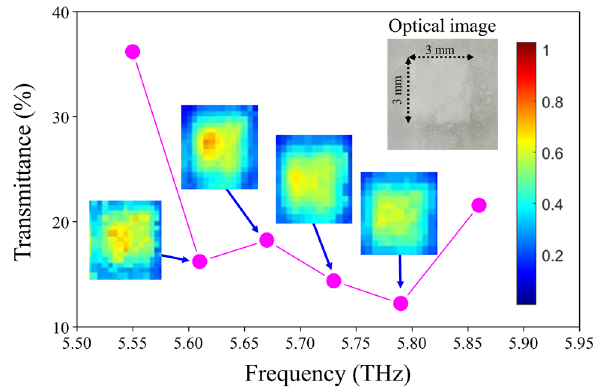
Figure 5. Spectral imaging of Aprovel powders. The characteristic transmittance curve of Aprovel powders between 5.55 and 5.87 THz. Insets: (false color) The THz transmittance images of the Aprovel powders between two polyethylene films scanned at 5.61, 5.67, 5.73, 5.79 THz, showing more transmission at 5.67 THz and less transmission at 5.79 THz over a spread area of 3 × 3 mm for the powders. (gray color) The optical image of the Aprovel sample between two polyethylene